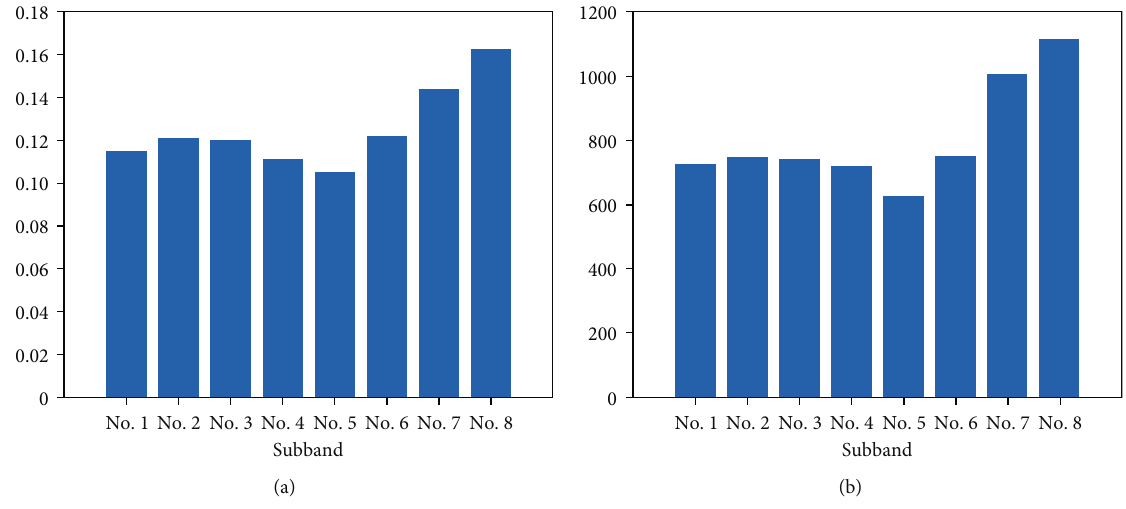
Figure 14: Wavelet decomposition subband energy ratio (a) and wavelet feature-scale entropy (b) of complete layer 2.